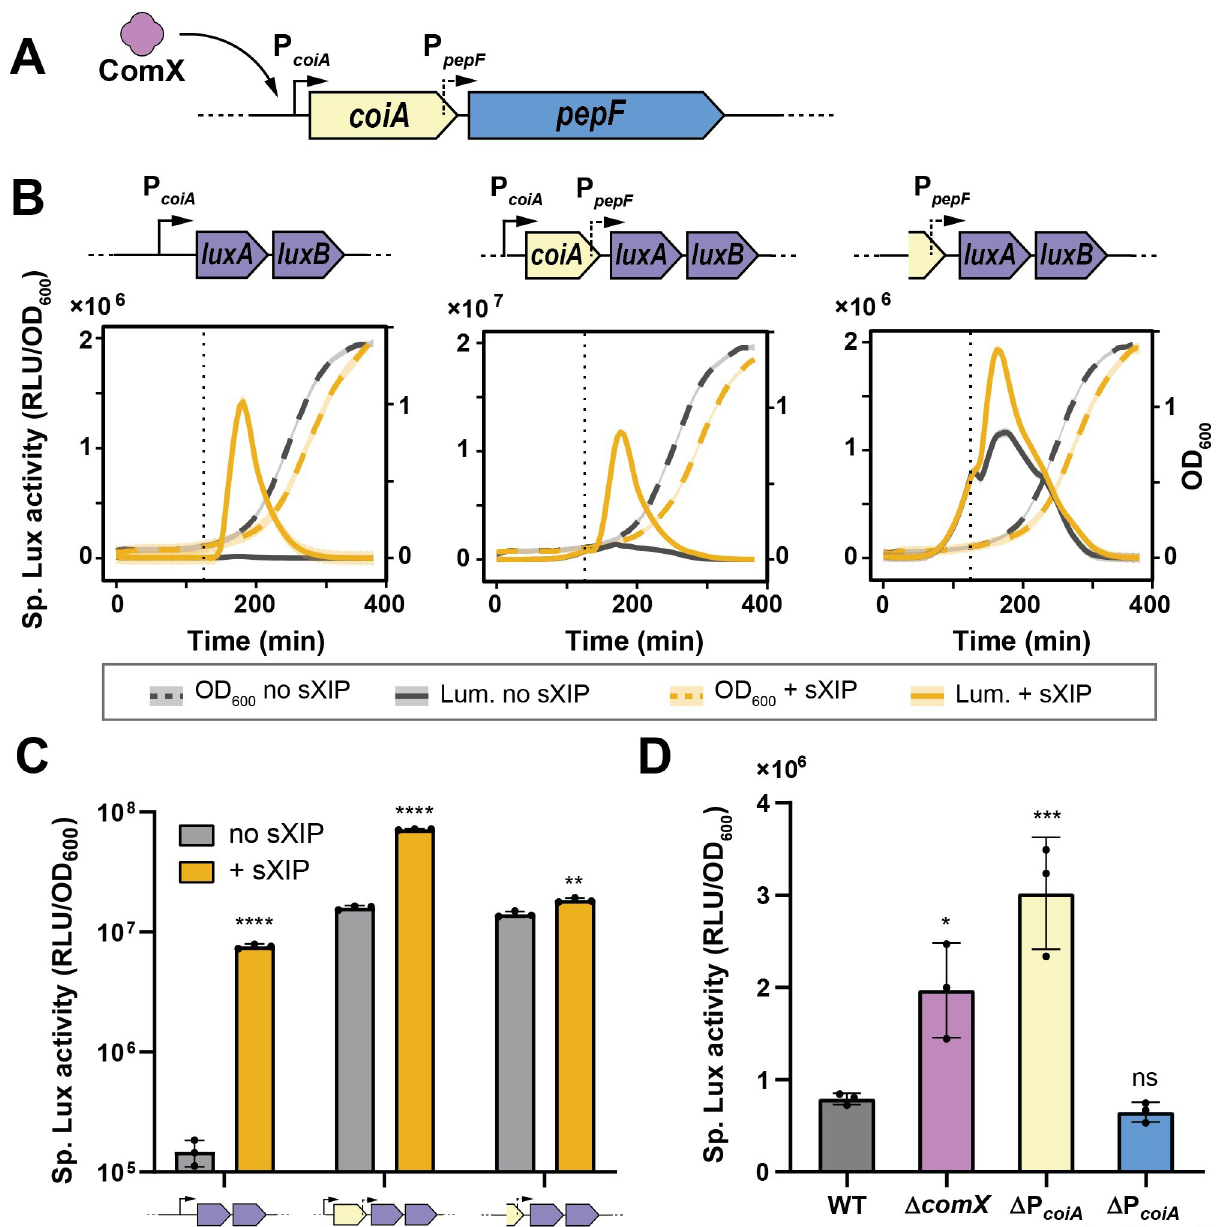
Fig 3. Transcriptional analysis of pepF and its ComX control. (A) Cartoon depicting the organization of the coiA-pepF operon. ComX controls P and a constitutive promoter of pepF was found in the coding sequence of coiA . (B) and (C) Kinetics (growth, OD 600 and Lux activity, Lum.) (panel B) and mean specific luciferase activity (RLU/OD 600 ) (panel C) reporting the transcription of the coiA-pepF operon upon competence activation. Lux activity was monitored with P , P P , and P luciferase reporter systems. The three constructs were incubated with (+ sXIP) coiA -luxAB coiA -coiA- pepF -luxAB pepF -luxAB or without (no sXIP) sXIP at a final concentration of 500 nM. sXIP was added after 120 min of growth (dotted lines in panel B) (D) Impact on competence activation of the ComX-control unplug on the expression of the coiA-pepF operon. Data show specific luciferase activity measured with a P comX -luxAB reporter strain (WT) and derivatives with comX deletion ( Δ comX ), P coiA deletion ( Δ P coiA ), and P coiA deletion complemented with an ectopic copy of a P operon ( Δ P + coiA-pepF ). Competence was activated thanks to a xylose-inducible promoter fused to comR (P coiA -coiA-pepF coiA xylose). In panel B, full lines and dashed lines are representative of the mean of biological triplicates, shaded lines depict standard deviation. In panels C and D, dots show biological triplicates, the bar shows the mean, and error bar the standard deviation. Statistical t -tests (panel C) or one-way ANOVA with Dunett’s test (panel D) were performed for each condition in comparison to the related mock to generate P values ( � , P < 0.05; �� , P < 0.01; ��� , P < 0.001, ���� , P < 0.0001; ns, non-significative).